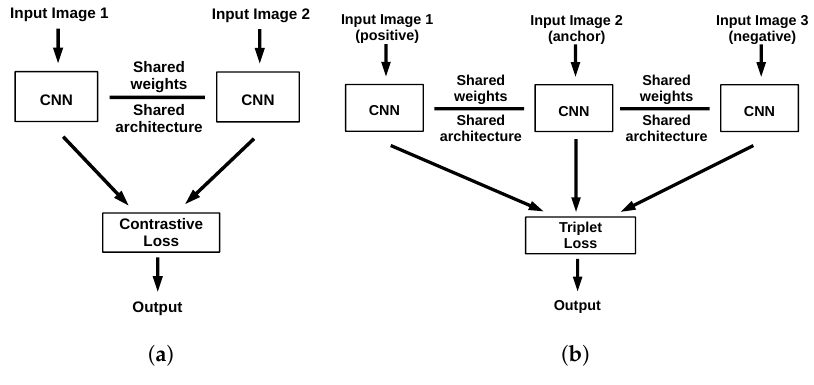
Figure 1. Outlines of common metric learning architectures. ( a ) Siamese architecture. ( b ) Triplet